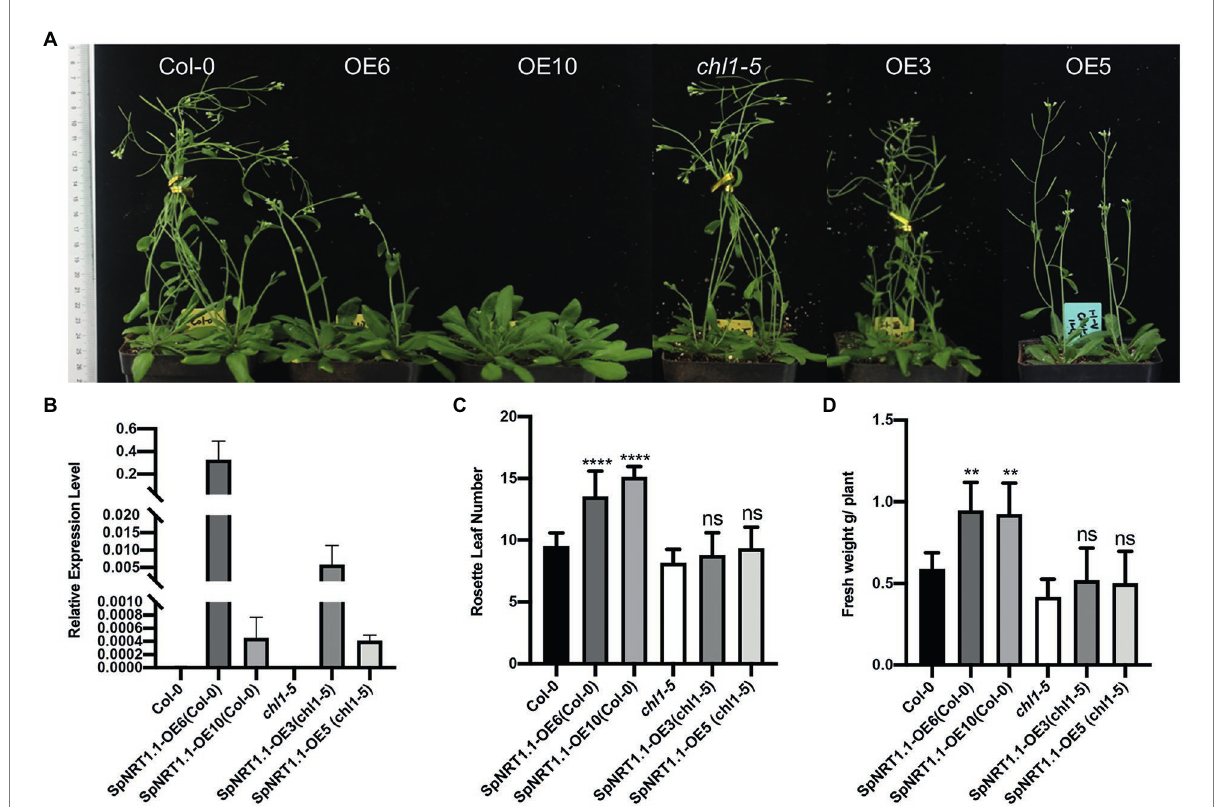
FIGURE 8 Overexpression of SpNRT1.1 in Col-0 and chl1-5 plants leads to late flowering time and improved biomass. Ordinary one-way ANOVA was used for statistical significance analysis, n ≥ 5, p < 0.05. (A) Phenotype of SpNRT1.1 overexpressed and complemented plants. (B) Relative expression level of SpNRT1.1 gene. Expression data display in Supplementary Table 8. (C) Rosette leaf number and (D) Fresh weight of SpNRT1.1 overexpressed and complemented plants. Student’s t -test was used for significant difference analysis. Asterisks indicate significance levels compared with chl1-5 mutant plants, ** p < 0.01, **** p < 0.0001, n ≥